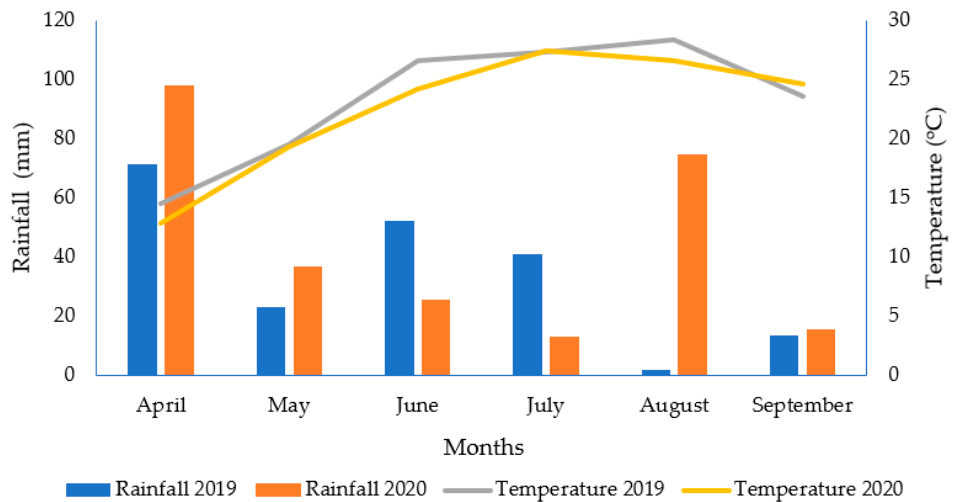
Figure 1. The main weather factors (average temperature and rainfall) for both years, 2019 and 2020, of the experiment in a commercial field crop in the area of Thessaloniki. The weather data were recorded with a weather station on site. recorded with a weather station on